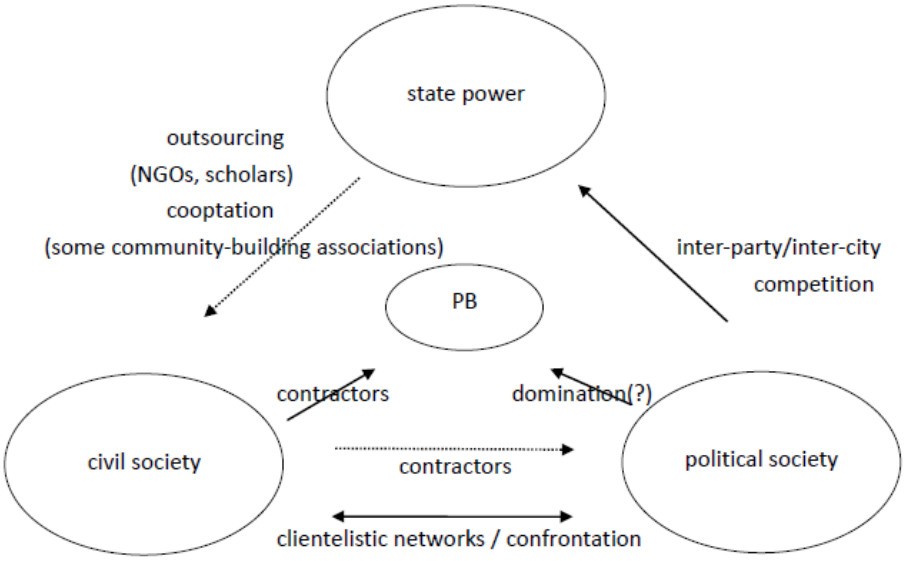
Figure 3 The state –civil society–political society analytical framework applied to PB in